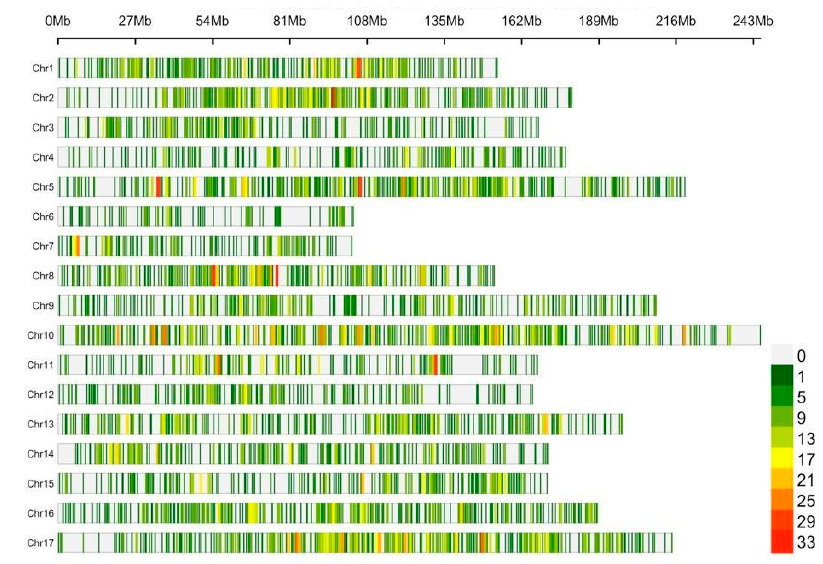
Figure 2. Distribution of SNPs along the 17 sunflower chromosomes. The colors indicate the number of markers within a 1 Mbp window.